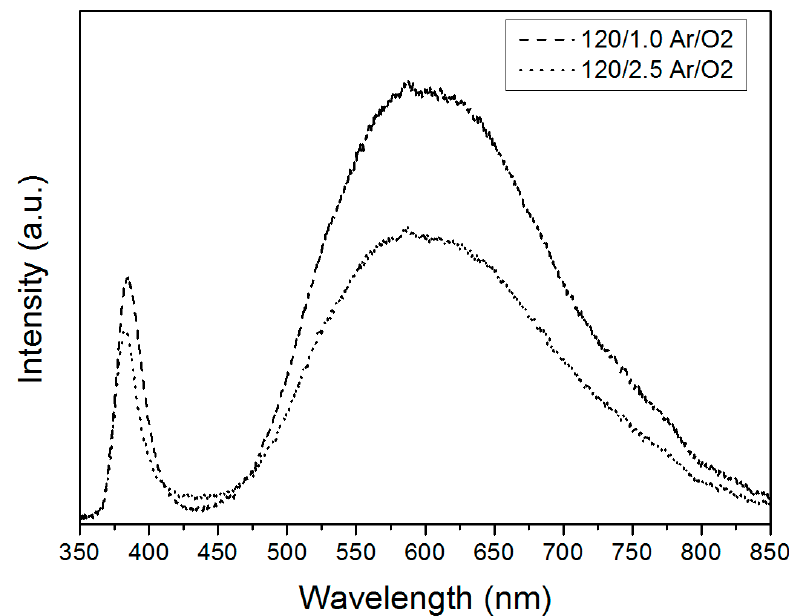
Figure 3. Photoluminescence (PL) spectrum of ZnO nanoplates and branched nanowires grown on Au-coated Si substrates in parallel setup with varying Ar / O 2 flow rates of 120 / 1.0 sccm (dotted line) and 120 / 2.5 sccm (dashed line).